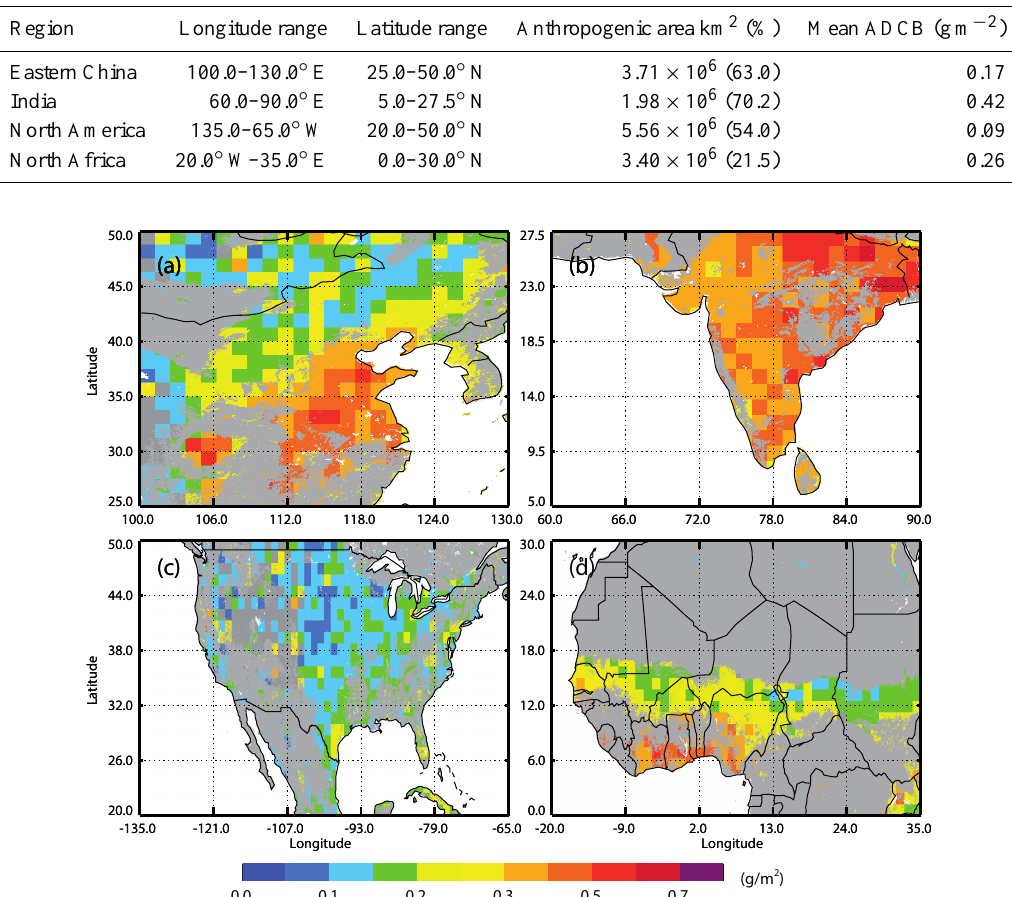
Figure 9. Regional distribution of annual mean anthropogenic dust column burden derived from CALIPSO measurements (2007 through 2010) for (a) eastern China, (b) India, (c) North America, and (d) North